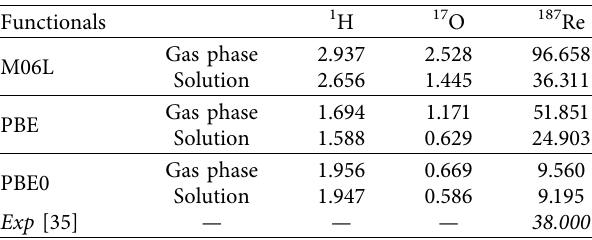
Table 3: Hyperfne coupling constants, A iso , in MHz, for three diferent functionals, in the gas phase and solution, using the relativistic efect (SARC-ZORA-TZVP for Re, TZVP for all other atoms, and ZORA in the